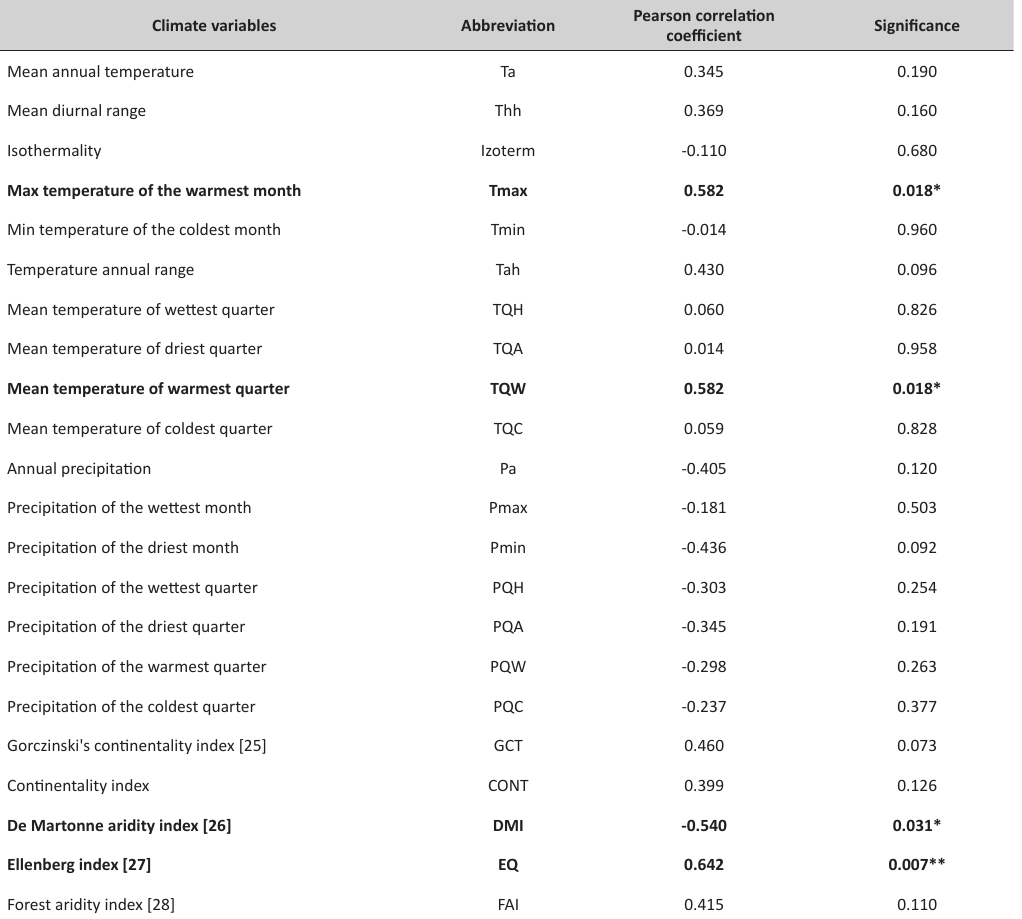
TaBle 2. A list of tested climatic variables and results of the correlation analysis data of original sites versus 15-year diameter in Bucsuta (variables significant at p<0.05 (*) and at p<0.01 (**) are